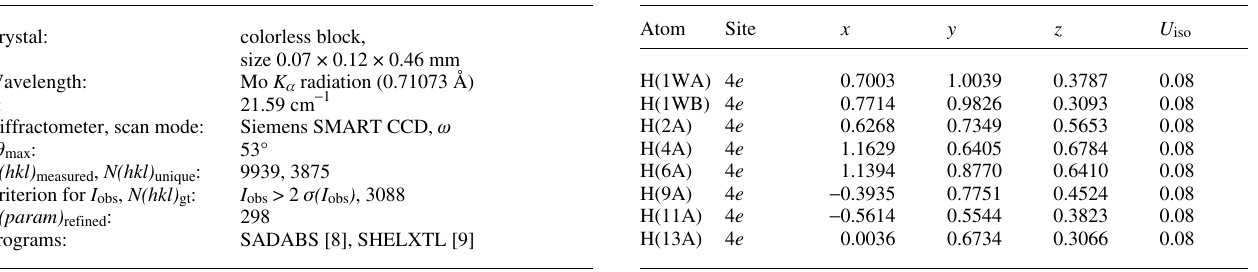
Table 3. Atomic coordinates and displacement parameters (in Å 2 ) .